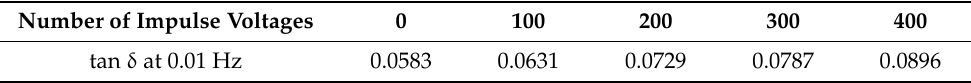
Table 3. The tan δ of oil-film dielectric under different numbers of impulse voltages at 0.01